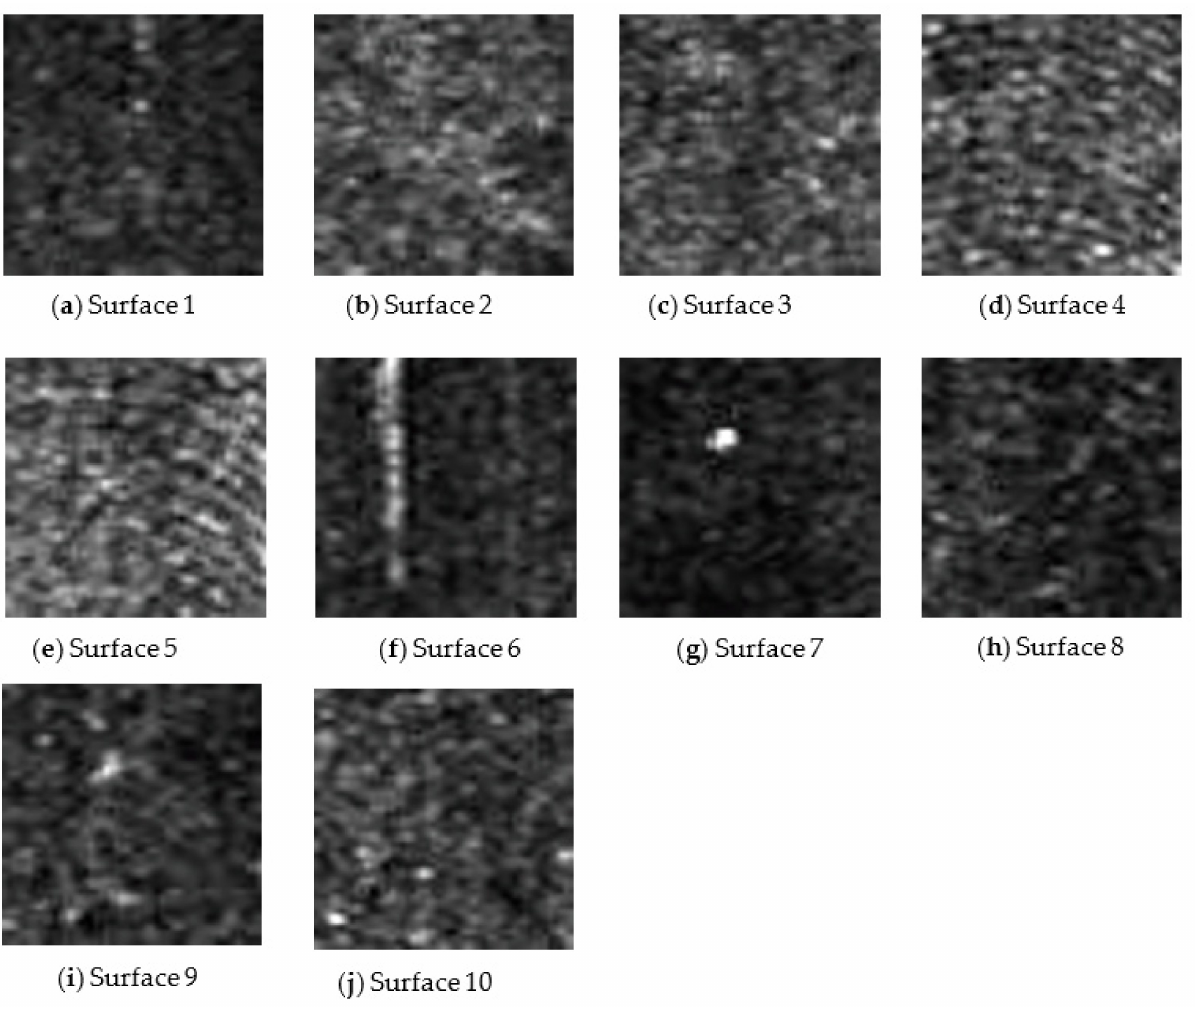
Figure 6. ( a – j ) The grayscale images of the laser speckle pattern image for each surface at an illumination angle of 45 ◦ , and f -number of